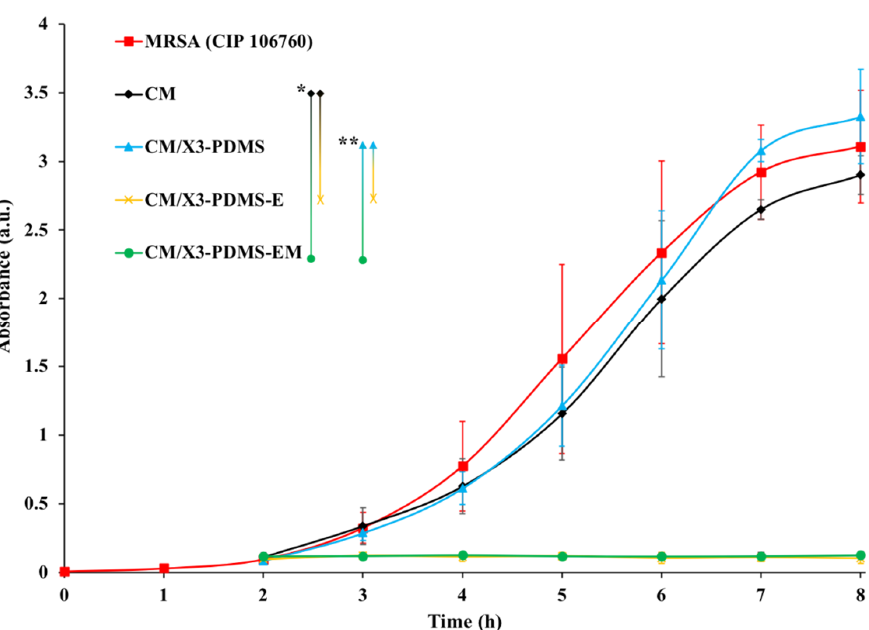
Figure 3. Antimicrobial activities against the bacteria methicillin-resistant S. aureus (MRSA), ex- pressed by the optical density (OD 620 nm ), obtained for uncoated (CM) and coated monolithic filters (200 cpsi, 1.5 cm × 1.5 cm × 2 cm) with polydimethylsiloxane-based coating: containing 0.56 wt.% of incorporated Econea (CM/X3-PDMS-E) or grafted Econea (CM/X3-PDMS-EM), and free of biocide (CM/X3-PDMS, control). The means ± standard deviations (SDs) for three independent tests are presented. Statistical analysis was performed by the Friedman test and the differences are indicated with * p < 0.05.